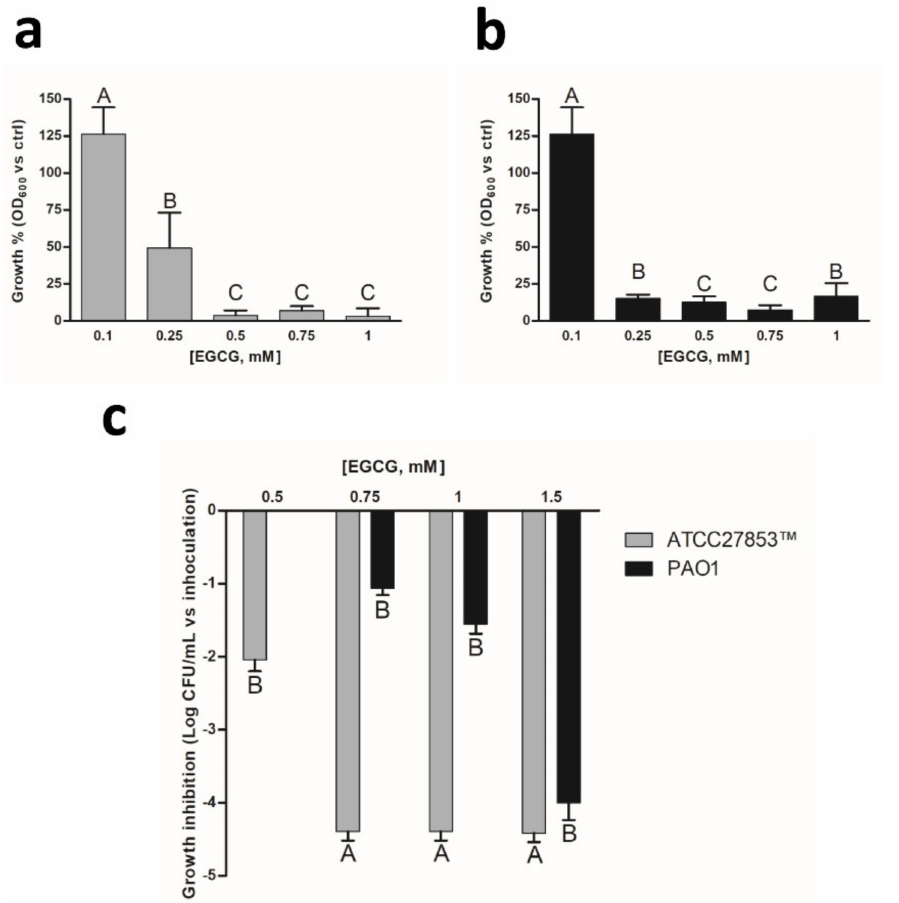
Figure 6. Inhibitory effect of free soluble EGCG on P . aeruginosa growth. Different concentrations of free soluble EGCG were assayed on P . aeruginosa ( a ) ATCC27853™ and ( b ) PAO1 strains. The growth percentages of each concentration with respect to the control are reported. ( c ) Delta growth inhibition after 24 h treatment with EGCG at the indicated concentrations. Different upper-case letters denote significant differences ( p < 0.01) between treatments according to pairwise compar- ison among concentrations. Mean values ± SD are reported. Contrasts were performed for each strain